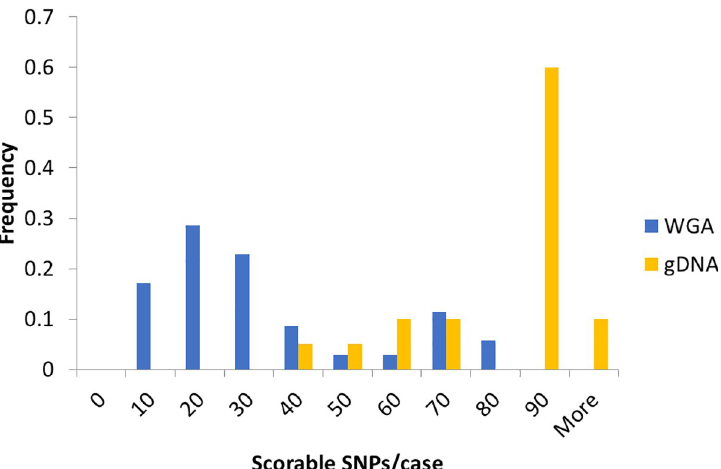
Fig 2. Comparison of the coverage of several genomic DNAs and NIPT single cells. The count of samples with various scorable SNPs was normalized to the total number of samples of each group (gDNA n = 20, WGA n = 35). The scorable SNP cutoff was at least 5% minor allele frequency (MAF) and ten reads. Data include NIPT case numbers 946, 977, 982, 983, 984, 988, 989, 990, 991, 992, 993, 996, and 998 (clinical data in S8